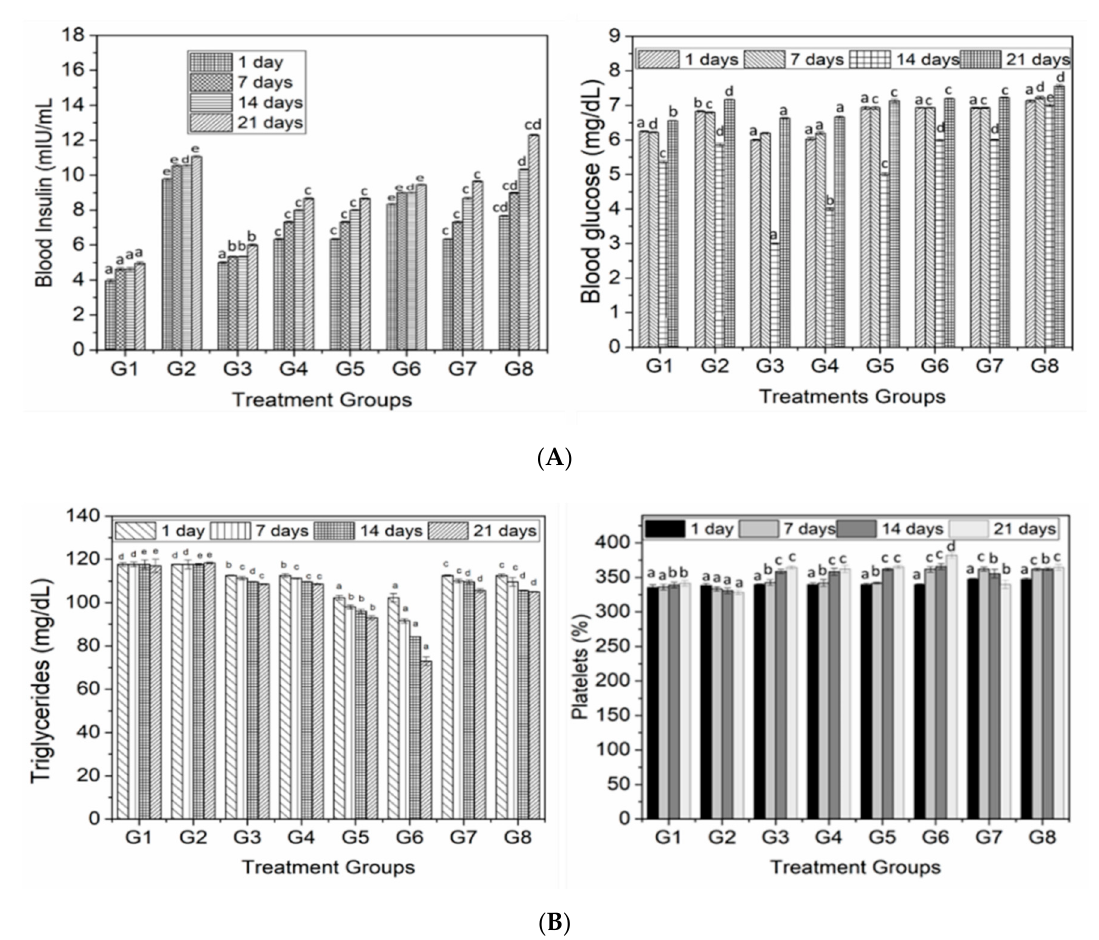
Figure 2. ( A ) Blood serum analysis of rats fed with different concentrations of polyphenol extract from guava leaves, seeds and pulp. Lowercase letters (a–e) show the significant difference ( p < 0.05) among treatments within the same time. ( B ) Triglycerides and platelets of mice fed with different concentrations of polyphenol extract from guava leaves, seeds and pulp. Lowercase letters (a–e) show the significant difference ( p < 0.05) among treatments within the same time. Table 3. Packed cell volume (PCV), mean corpuscular volume (MCV) and the hemoglobin levels of diabetic and control mice fed with different concentrations of polyphenol extract of guava leaves, pulp and seeds.